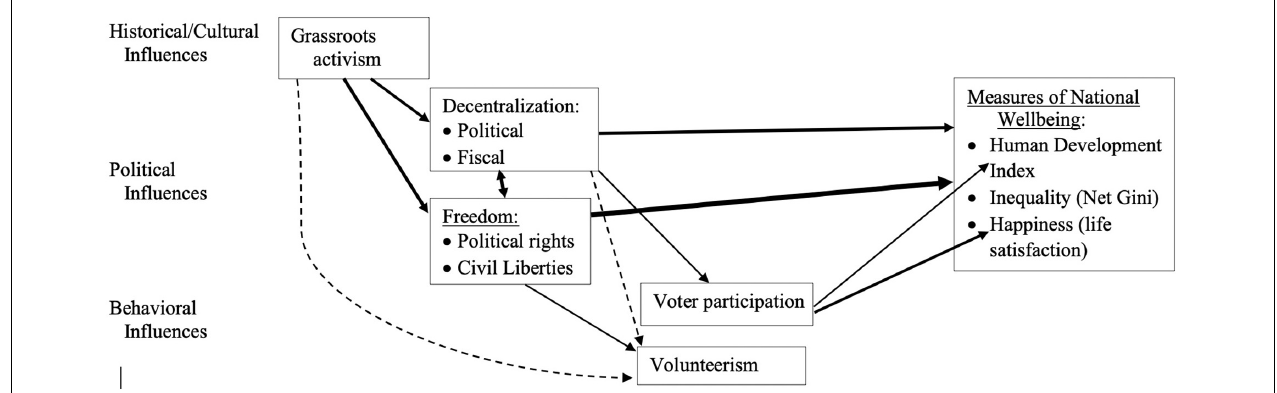
FIGURE 2 | Confirmed Political, Social Justice, and Citizenship Predictors and Measures of National Well-being.